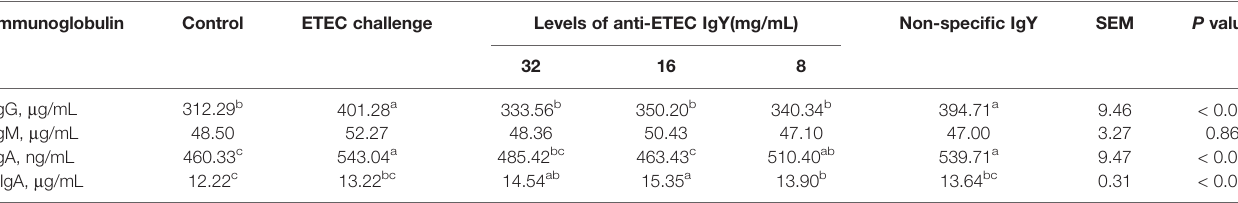
treated with PBS. Mice in IgY groups were challenged with ETEC K88 and treated with 250 m L of high-, medium- or low-doses of anti-ETEC IgY or 250 m L of non-speci fi c IgY.